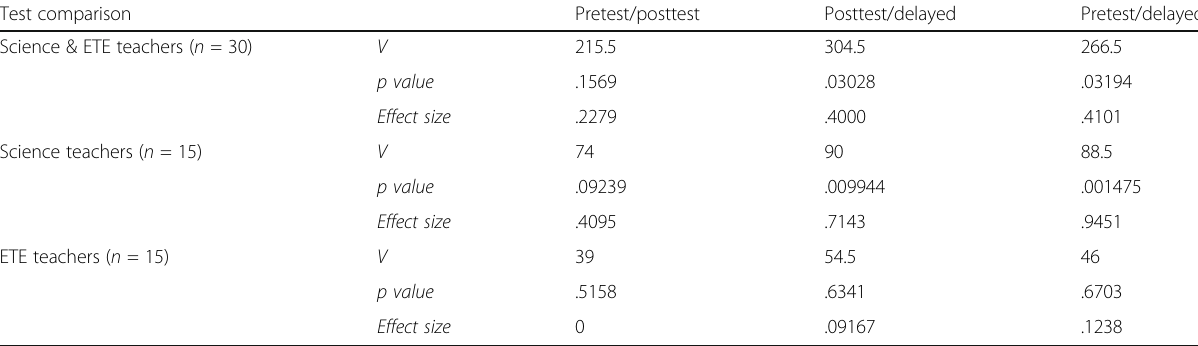
Table 6 Summary of statistical tests for significant differences for the experimental group (V, p value and effect size) Test comparison